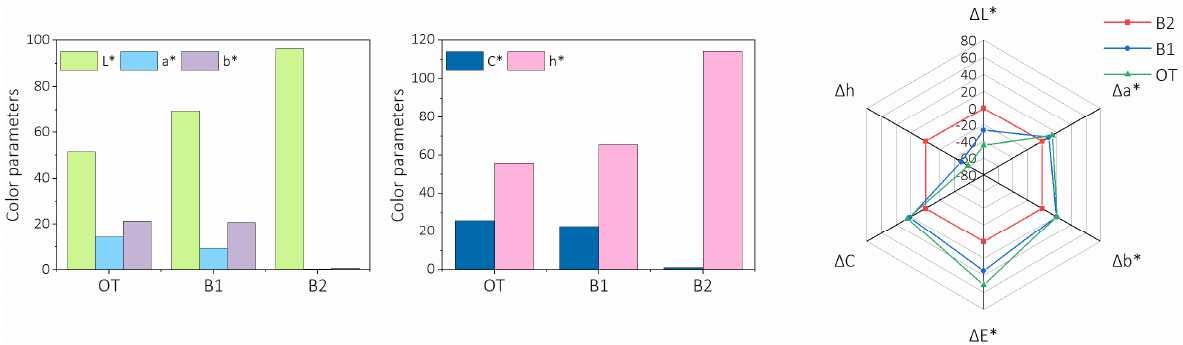
Figure 6. Color properties of the elaborated films.